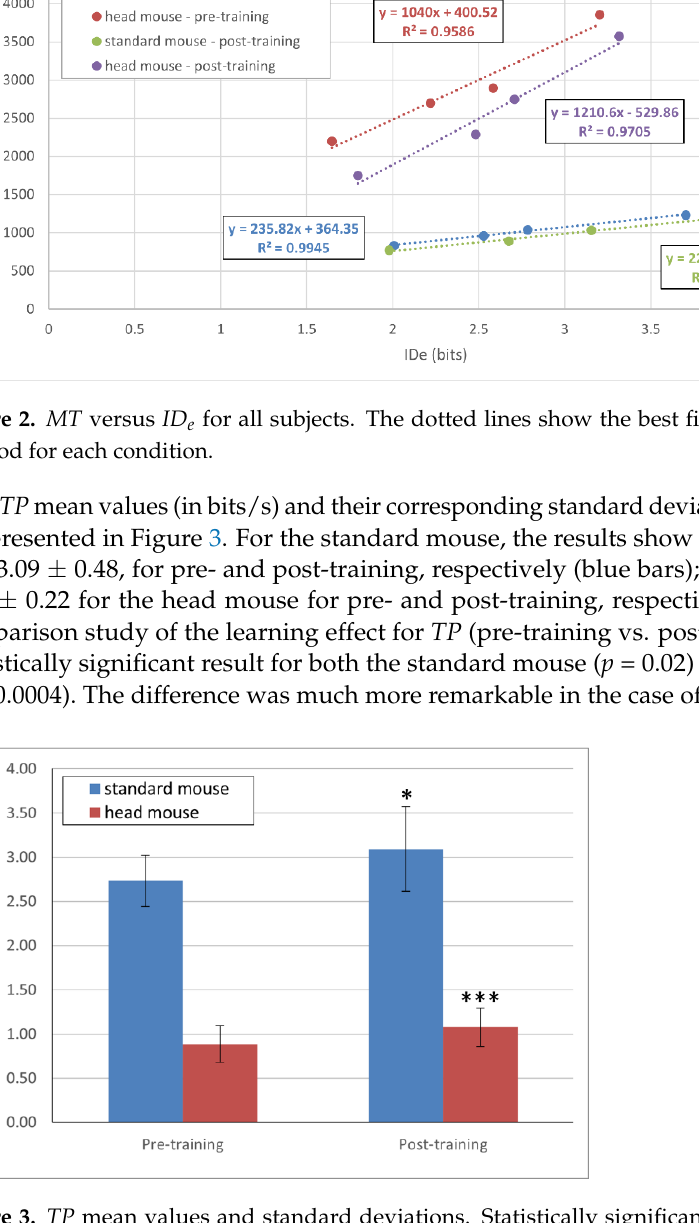
Figure 3. TP mean values and standard deviations. Statistically significant changes for both the standard mouse and the head mouse ( p < 0.05 [*] and p < 0.001 [***] respectively) comparing pre- and post-training.